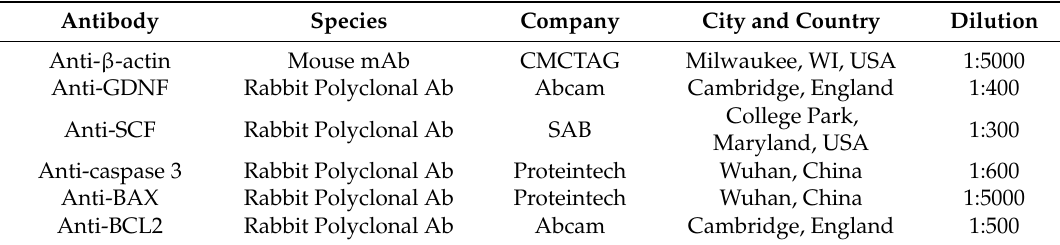
Table 1. Antibodies used for Western